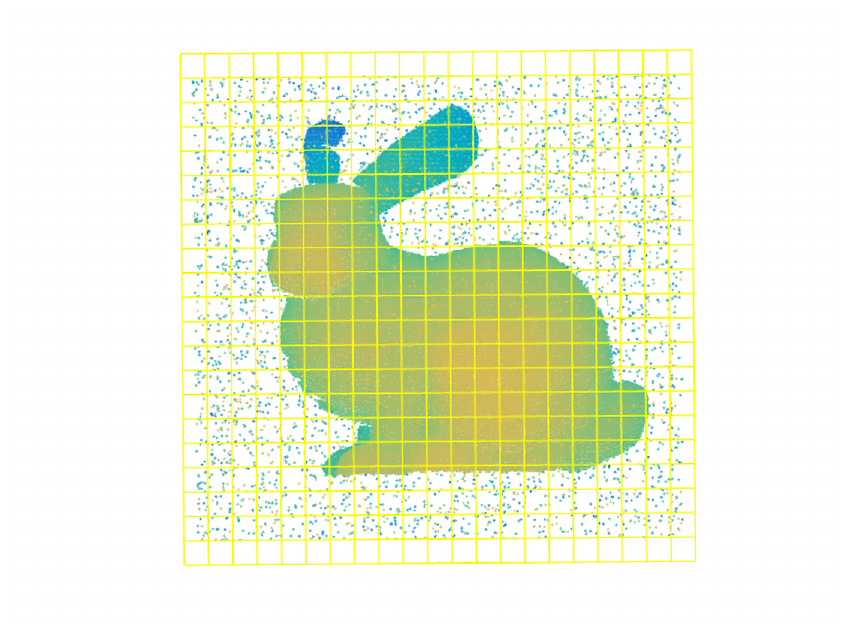
Figure 2. Illustration of the improved voxel filter. The density of points in different voxel grids is not equal, so the threshold can be set to eliminate